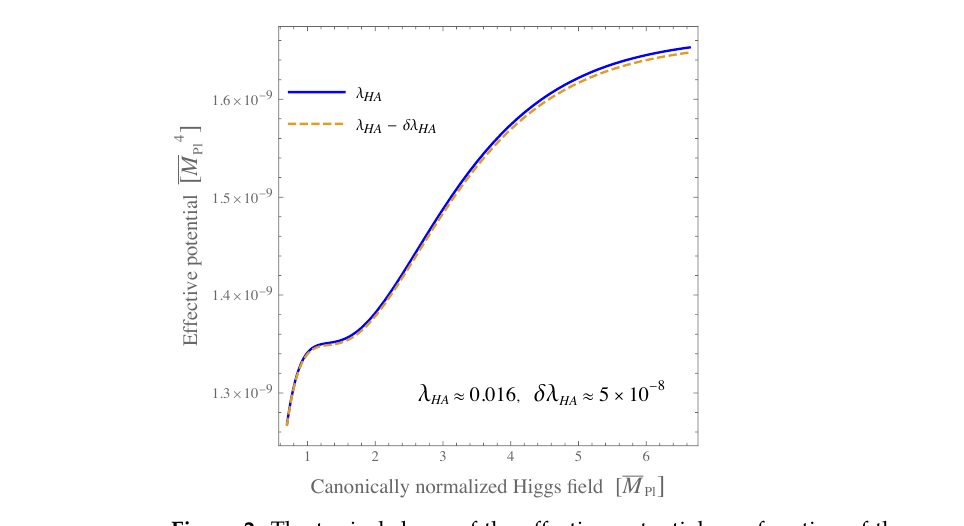
Figure 2. The typical shape of the effective potential as a function of the canonically normalized Higgs field close to criticality (in this plot, we approach the critical regime by varying λ HA ).